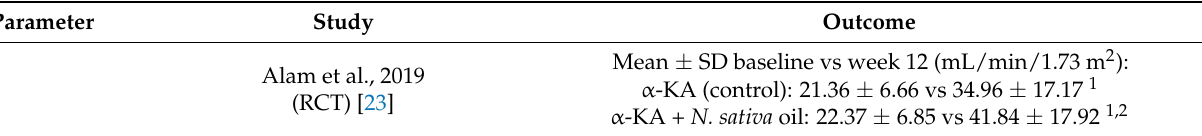
Table 3. Results from studies that examined renal